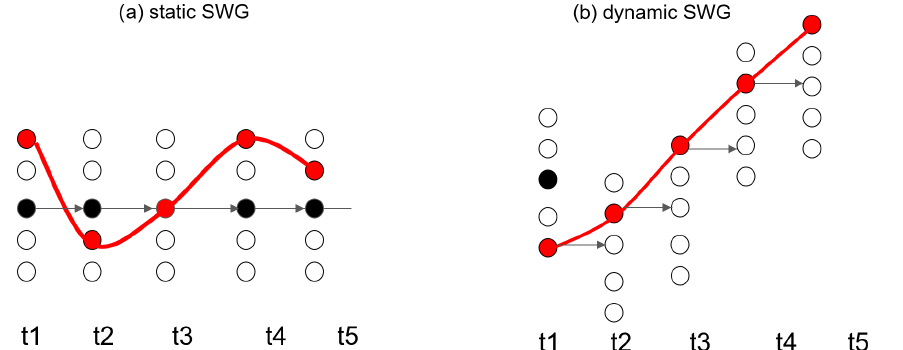
Figure 2. Illustration of the analogue-based importance sampling. (a) The static SWG replaces each day in the observed trajectory (black dots) with one of its analogues (red dots). (b) The dynamic SWG replaces the first day in the observations (black dot) with one of its analogues, reads the following day of this analogue, and repeats the procedure until creating a new trajectory (red